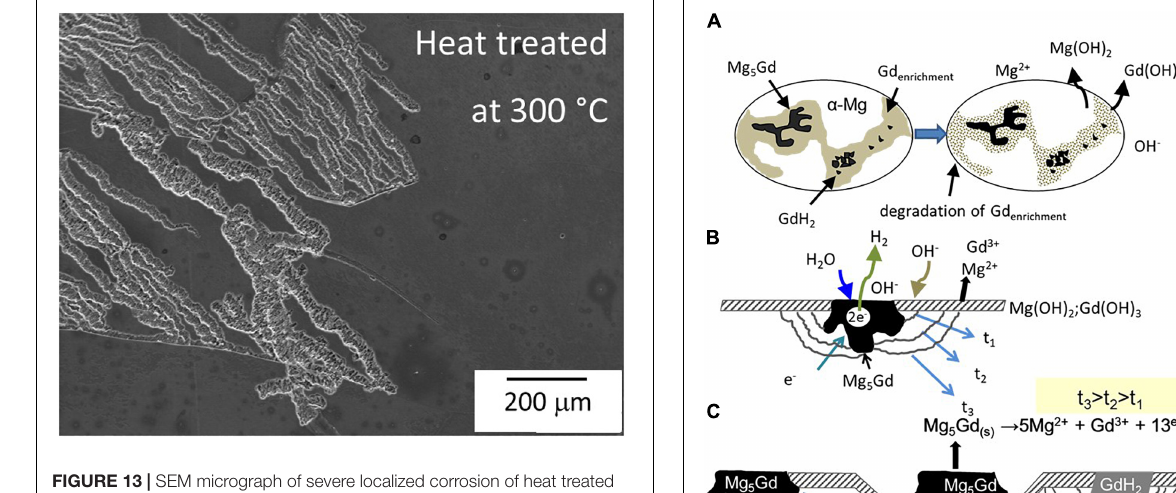
(Mg 5 Gd/GdH 2 ) phases (Song and Atrens, 2003). EDX analysis